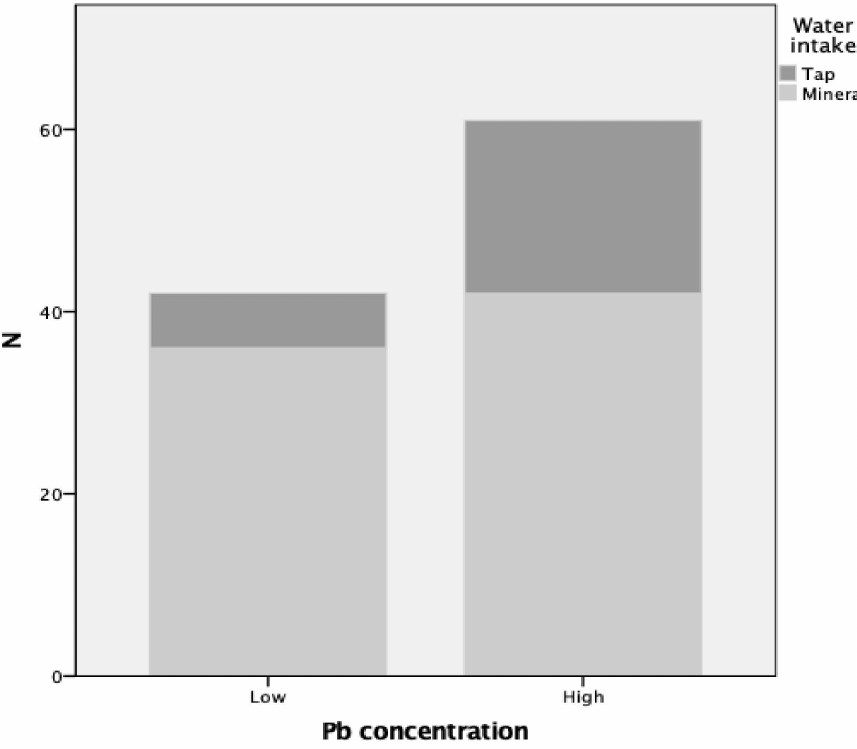
Figure 4. Consumption of tap water and mineral water as a function of Pb